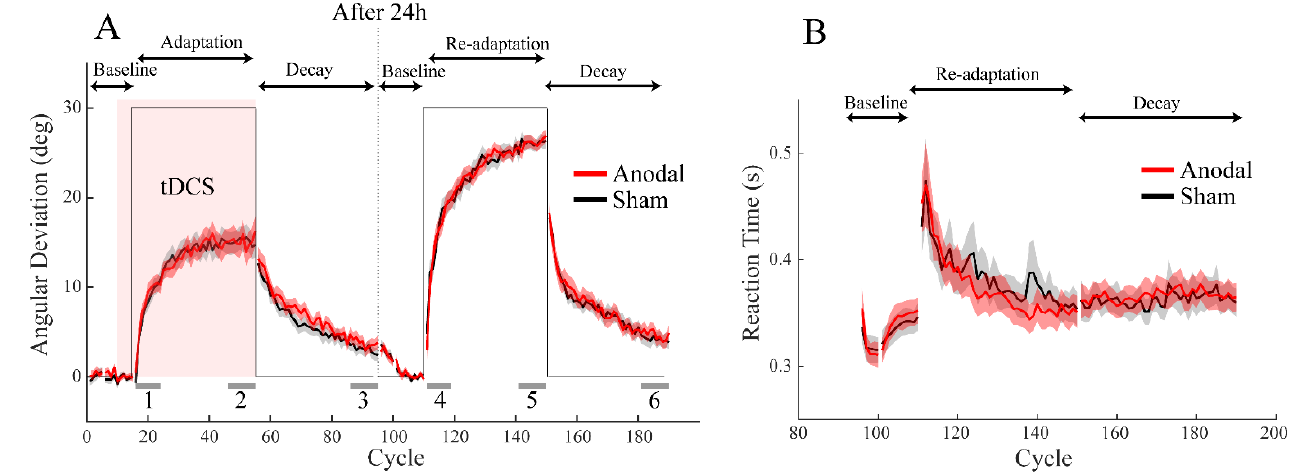
Figure 2. Adaptation performance in Experiment 1. ( A ) The angular deviation as a function of trial cycles over two days. The group average (line) and standard error across participants (shade) are shown. The anodal and sham groups are plotted in red and grey, respectively. The experimental phases are marked by arrows on top of the figure. The red rectangular area denotes the duration of the ctDCS application. The solid black line denotes the error clamp/rotation perturbation. The grey segments on the bottom of the figure show the windows for calculating performance measures: 1 and 4 are for the adaptation and re-adaptation rate, respectively; 2 and 5 are for the adaptation and re-adaptation extent, respectively; 3 and 6 are for the decay residues in the two days. ( B ) Reaction time as a function of trial cycles for the baseline and the re-adaptation phases on day 2. There was a marked increase in RT when the visuomotor rotation was unexpectedly applied.